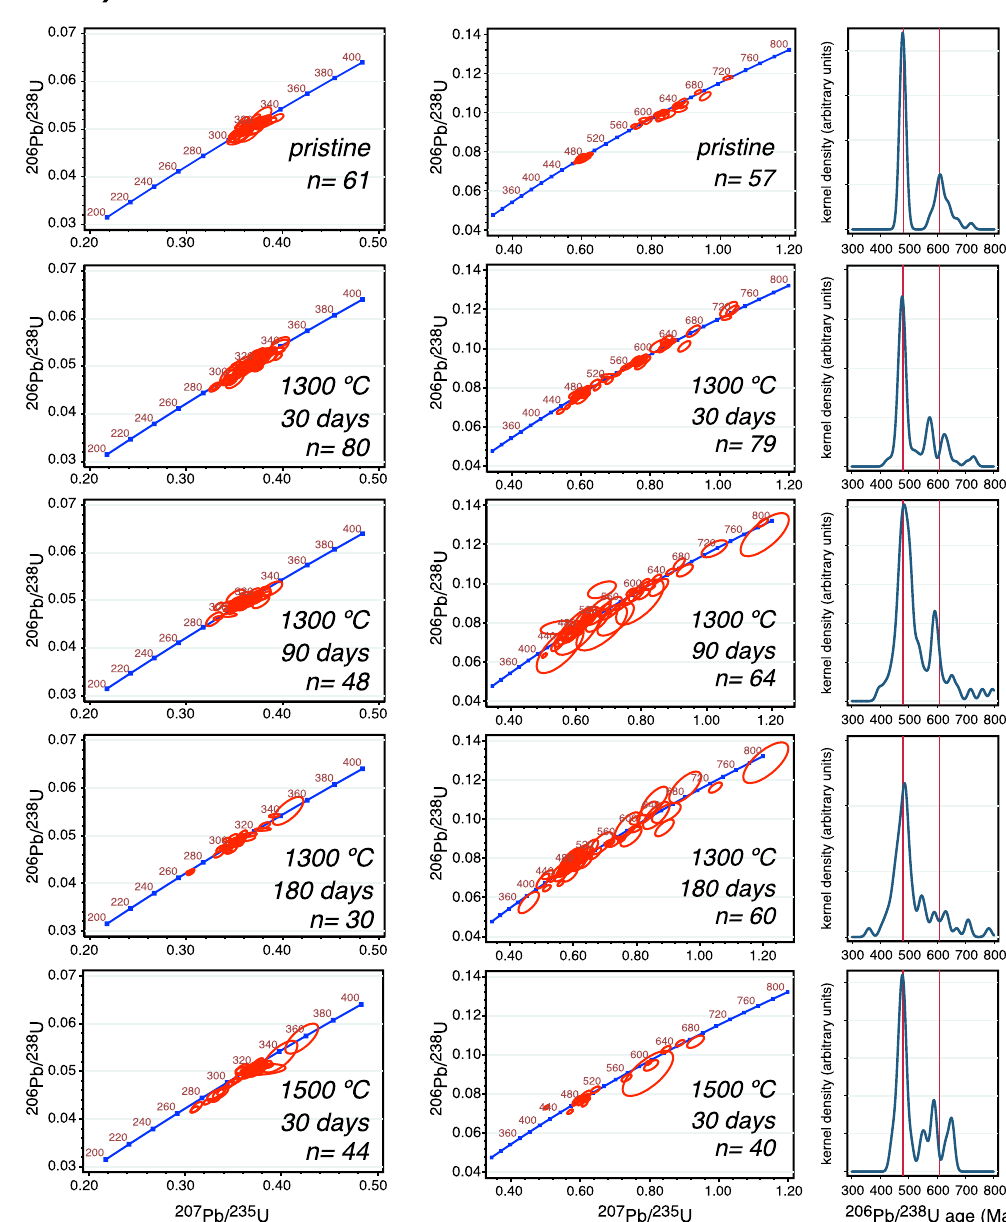
Figure 2. Experimental results. ( A ) Wetheril concordia plots of the heated zircon grains from the tonalite SAB51. ( B ) Wetheril concordia plots and distribution of 206 Pb/ 238 U ages of the heated zircon grains from the orthogneiss SAB50. Note how the spots representing the tonalite SAB51 spread up and down with increasing heating time and/or temperature producing both, direct and reverse discordant ages. The orthogneiss SAB50 shows the same effect in the rims, and a loss of definition in the age of the cores, with the appearance of new modes corresponding to mixed